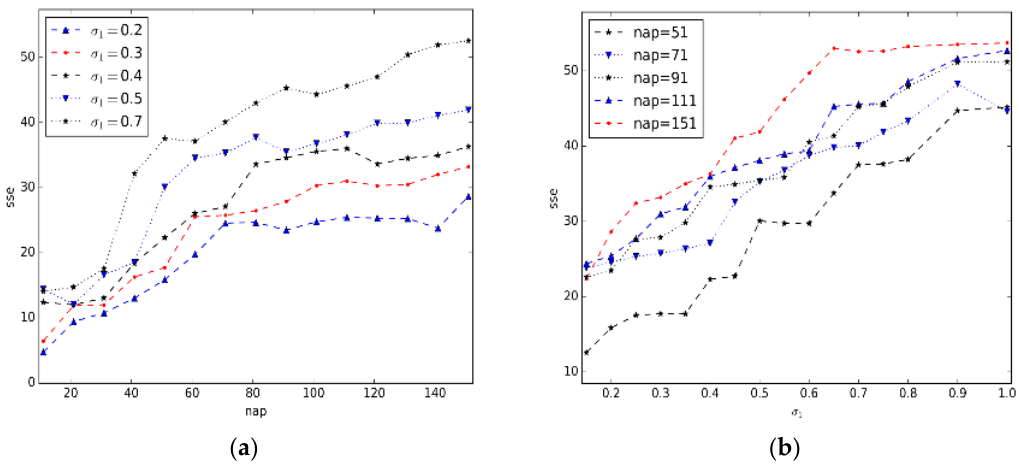
Figure 9. The sse (sum of squared error) with different values for parameters Nap and 𝜎 1 . ( a ) The sse for different Nap ; ( b ) the sse for different 𝜎 1 .